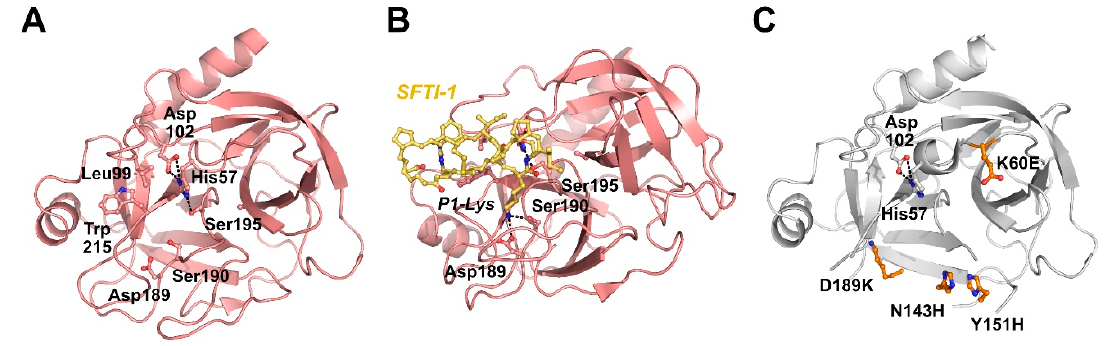
Figure 7. Trypsin ligase properties and trypsiligase. ( A ) The prototypic bovine β -trypsin structure (PDB 1TLP). The catalytic triad and specificity determining residues are shown as ball-and-stick models. ( B ) Trypsin bound sunflower trypsin inhibitor-1 (SFTI-1) in the active site with a scissile bond that is religated in the thermodynamic equilibrium (PDB 1SFI). The major specificity determinant is P1-Lys, while several prolines and an internal disulfide rigidify the cyclic inhibitor. ( C ) Trypsiligase derived from rat trypsin II with the four crucial mutations (orange) depicted as ball-and-stick side-chains (PDB 4NIV). The crystal structure shows a zymogen-like conformation, with large disordered regions around the catalytic Ser195, the S1 pocket and the 148-loop. Only the Lys60Glu mutation could be confirmed by electron density. The mutant residues Asn143His, Tyr151His, and Asp189Lys were modeled according to the positions in mature bovine trypsin.